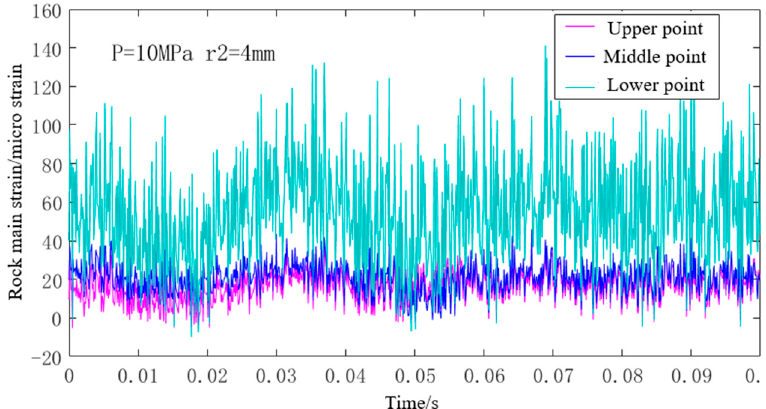
Figure 5. Original data of rock dynamic strain impacted by 10 MPa ASJ.